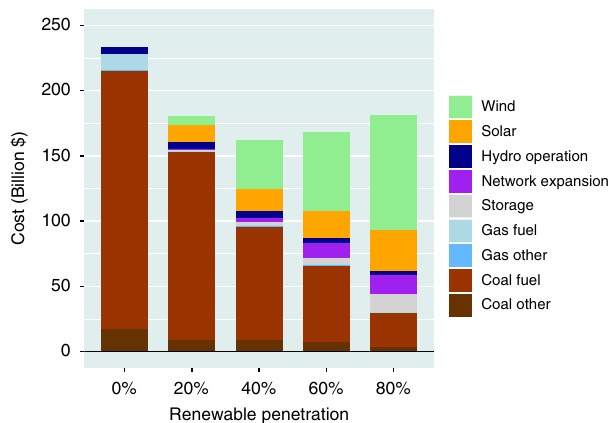
Fig. 5 National power system costs. Annual costs for the 2040 power system estimated on the basis of the standard model for different levels of renewables. Coal fuel and gas fuel refer to the costs for fuel for the existing and expanded coal and gas- fi red plants. Coal other and gas other refer to the amortized capital and operational and maintenance costs for the new plants.